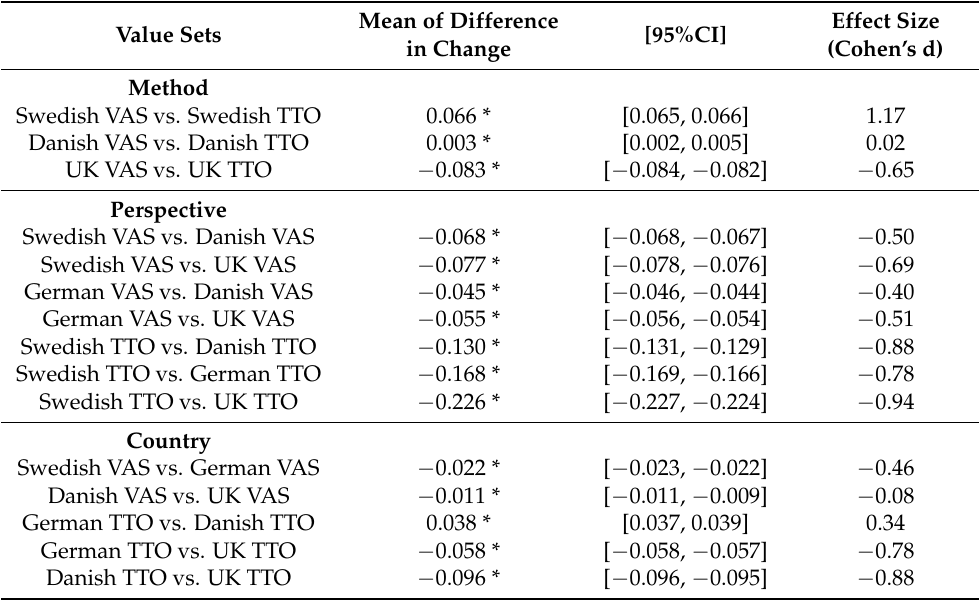
Table 4. Paired-sample t test of mean difference in change of EQ-5D-3L indices between value sets 1 year postoperatively (n=